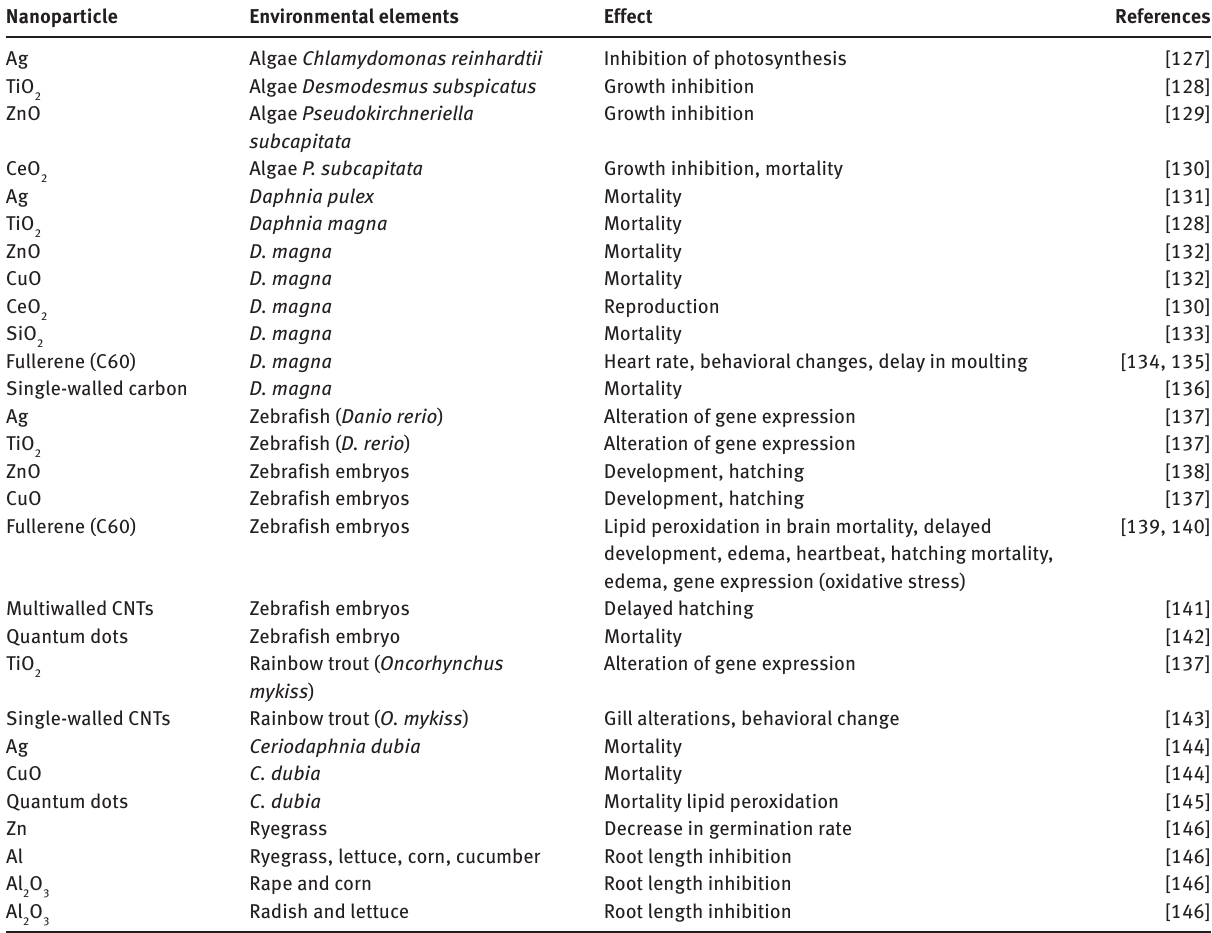
Table 2: Environmental impacts of nanoparticles.